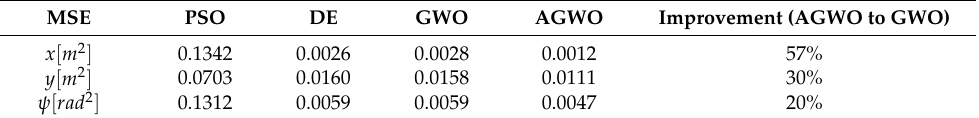
Table 1. The mean square error (MSE) in trajectory tracking for each optimization algorithm.